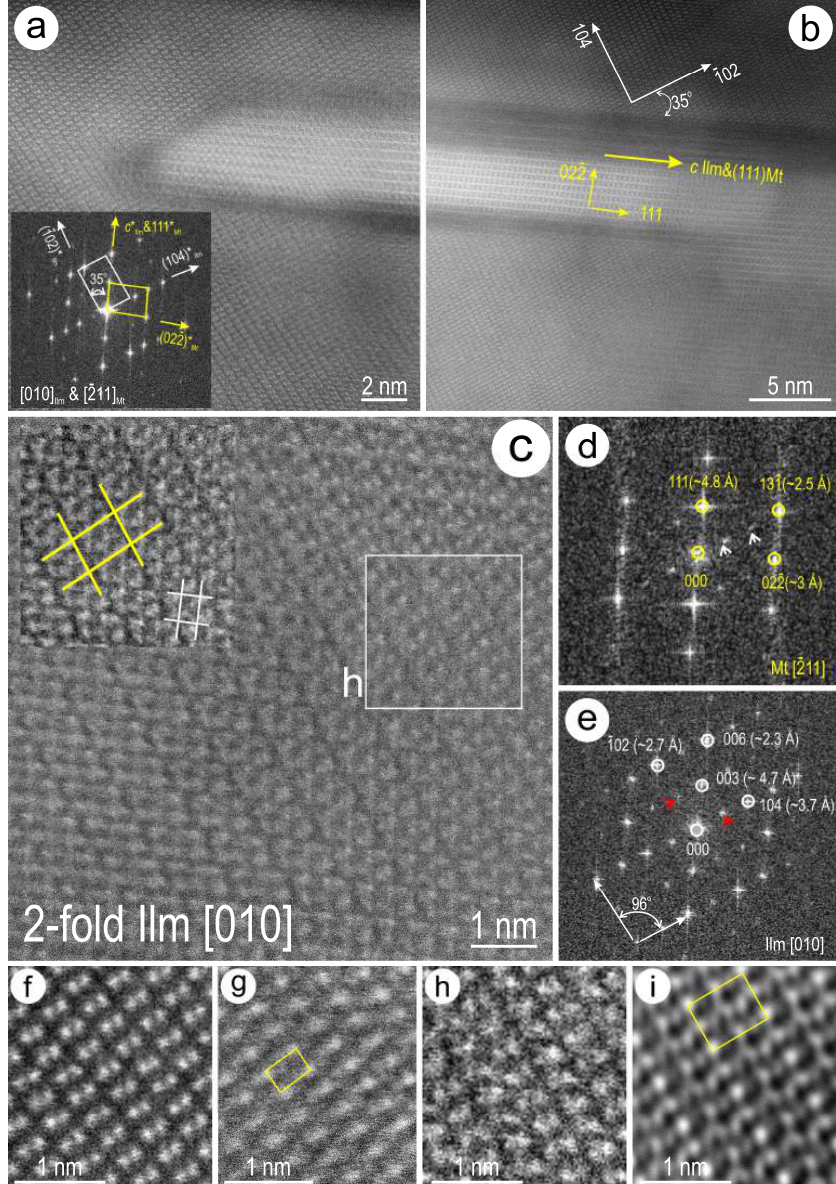
Figure 13. ( a , b ) HAADF STEM images showing orientation between the V-rich, Ti-poor magnetite lamellae (Mt; bright) in host ilmenite (Ilm) from Figure 10d. FFT pattern shown as inset indicates c* Ilm is parallel to (111)* Mt . White and yellow rectangles highlight the coherent intergrowth between ilmenite and magnetite, respectively. ( c ) High-resolution HAADF STEM image of ilmenite showing 2-fold superstructuring in the vicinity of the magnetite lamella. Inset shows an overlap between the magnetite (white lines) and the double-sized cell of ilmenite (yellow lines). ( d ) FFT obtained from magnetite showing two satellite reflections along (131(cid:3364)) * due to intergrowths with a two-fold ilmenite structure (white arrows). ( e ) FFT obtained from ilmenite showing the presence of satellite reflections (red arrows) due to the superstructuring, as shown in ( c ). ( f , g ) Ilmenite on the [010} zone axis (cropped from Figure 11a) and noise-filtered Z-contrast image showing the size of the smallest motif arrangement (yellow rectangle). ( h , i ) Superstructure of ilmenite from the rectangle marked in ( c ) and noise-filtered Z-contrast image showing the structural motif (yellow rectangle), which is double-sized relative to the motif in ( g ).